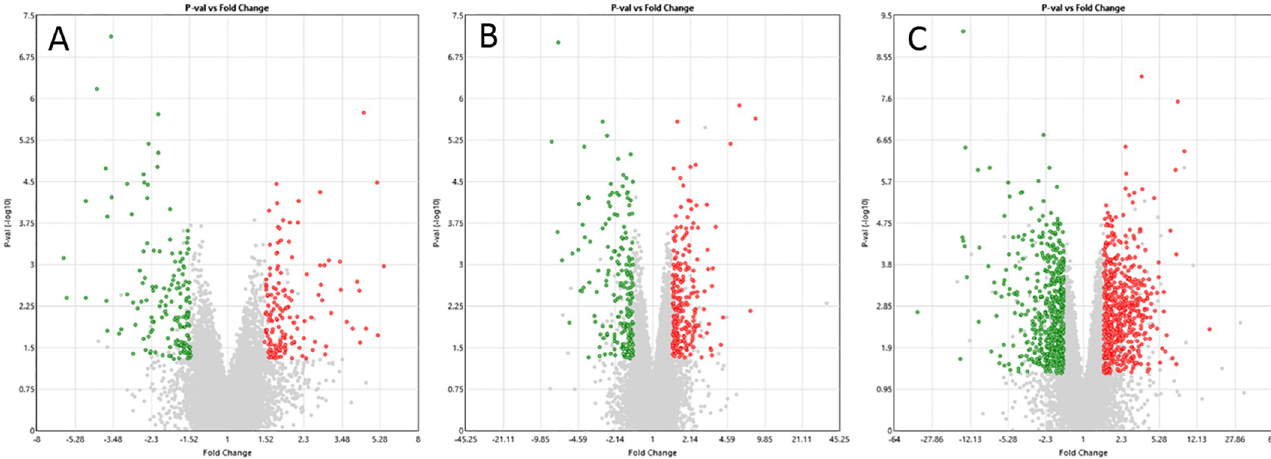
Fig 5. Volcano plots comparing qVICs to aVICs and the effect of treatments on VICs. Red dots represent up-regulated genes, green represent genes that were down-regulated and uncoloured are genes which do not pass the differential expression criteria. The X-axis shows fold change value and the Y-axis shows the P- value. (A) Genes differentially expressed between qVICs + vehicle and qVICs treated with TGF β 1. (B) Genes differentially expressed between aVICs + vehicle and aVICs treated with SB431542. (C) Differentially expressed genes between qVICs and aVICs. Statistical analysis was performed with paired or unpaired ANOVA.